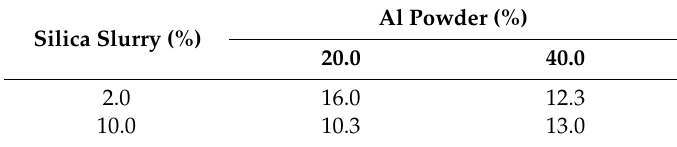
Figure 1. Orthogonal experimental effects of the ( A ) Al powder, ( B ) silica slurry concentration and (C) UV drying time. Table 3. Interaction table between the silica slurry and Al powder. Table 3. Interaction table between the silica slurry and Al powder.